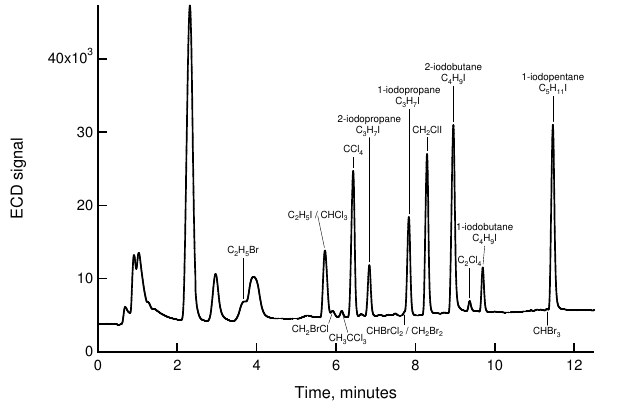
Fig. 9. Chromatogram of a laboratory air sample from µ Dirac af- ter spiking the laboratory air with traces of nine different halocar- bons: bromoethane (C 2 H 5 Br), iodoethane (C 2 H 5 I), 1-iodopropane